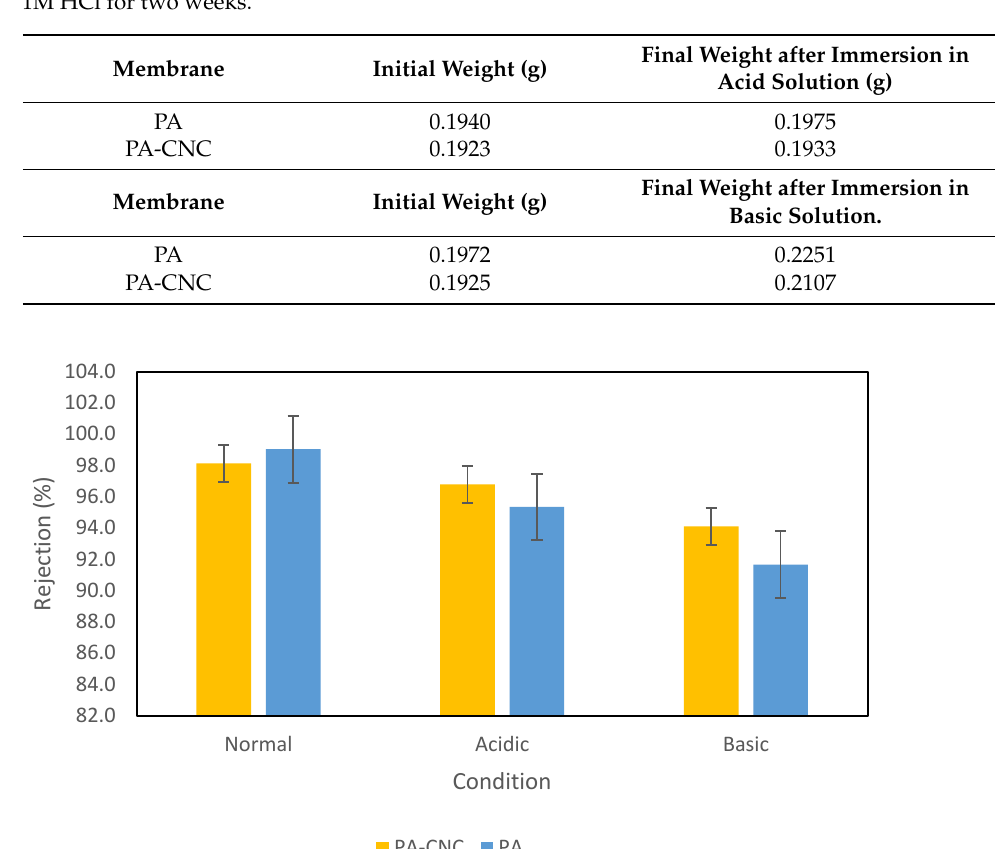
Figure 6. Sodium chloride (1500 ppm) rejection for the membranes where normal is for the membrane before soaking, Acidic is for after soaking in 1 M HCl and alkaline is for after soaking in 1 M NaOH.